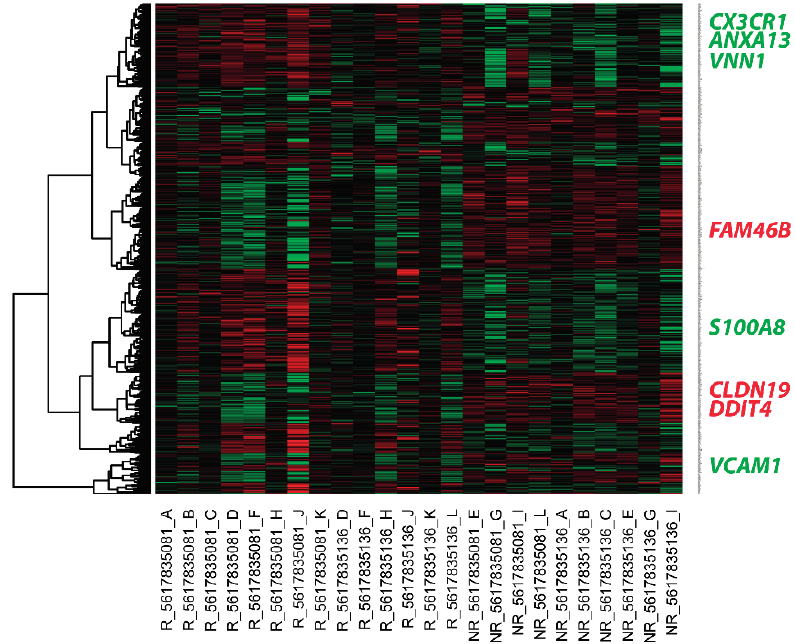
Figure 1. Heat map of the differential gene expressions between the lupus nephritis (LN) responder and non-responder patients. The upregulated genes are shown in red, while the downregulated genes are shown in green. Each column represents an individual kidney sample. R: LN responder patient; NR: LN non-responder patient. Gene names are indicated on the right. All validated candidate biomarkers are highlighted in green text for upregulated genes and red text for downregulated